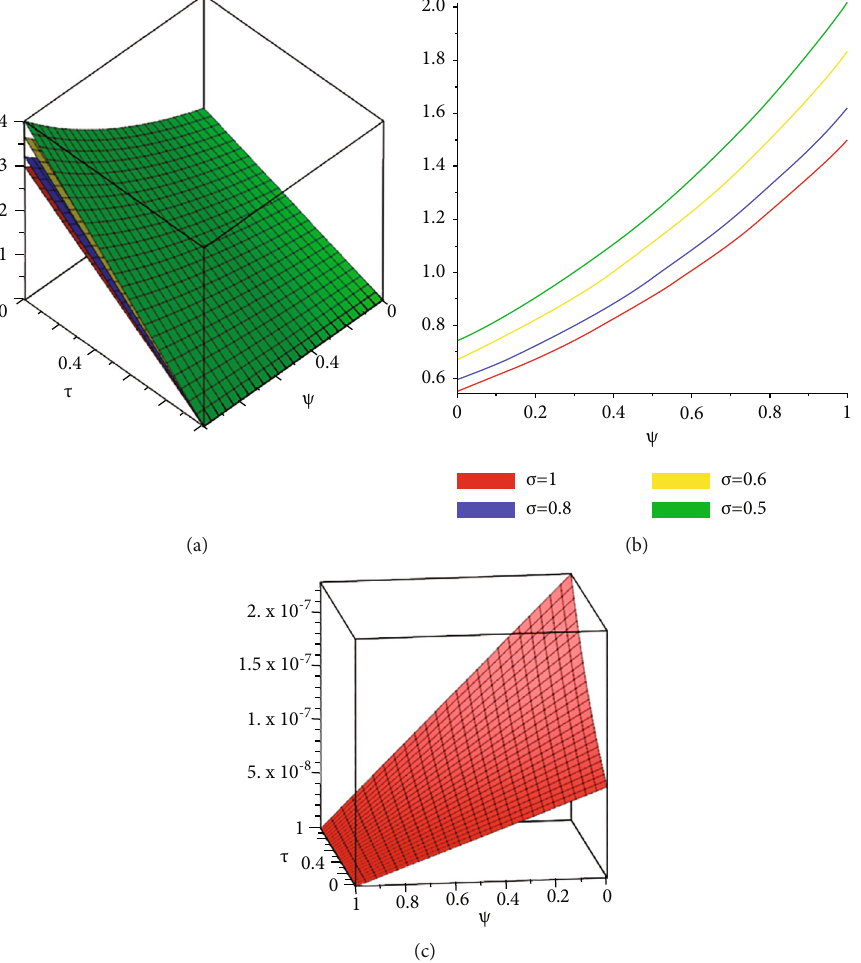
Figure 5: Example 3. (a) Analytical solution at various fractional orders of σ (b) ϕ = 0 : 5 and (c)